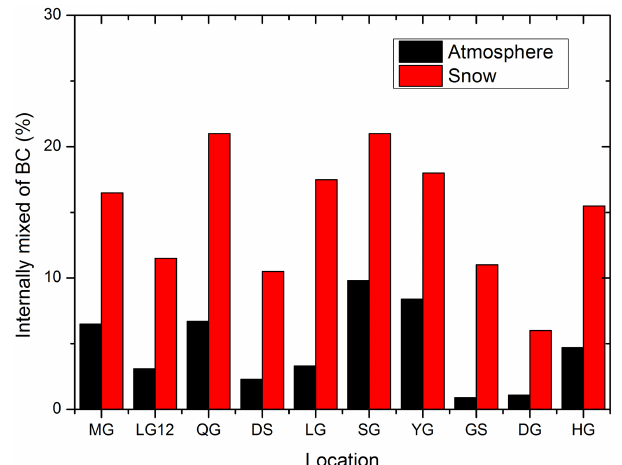
Figure 9. The proportion change of internally mixed BC particle with other particles showing an obvious increase of internally mixed BC / OM in glacier–snowpack compared with that in the atmosphere in summer 2016–2017.